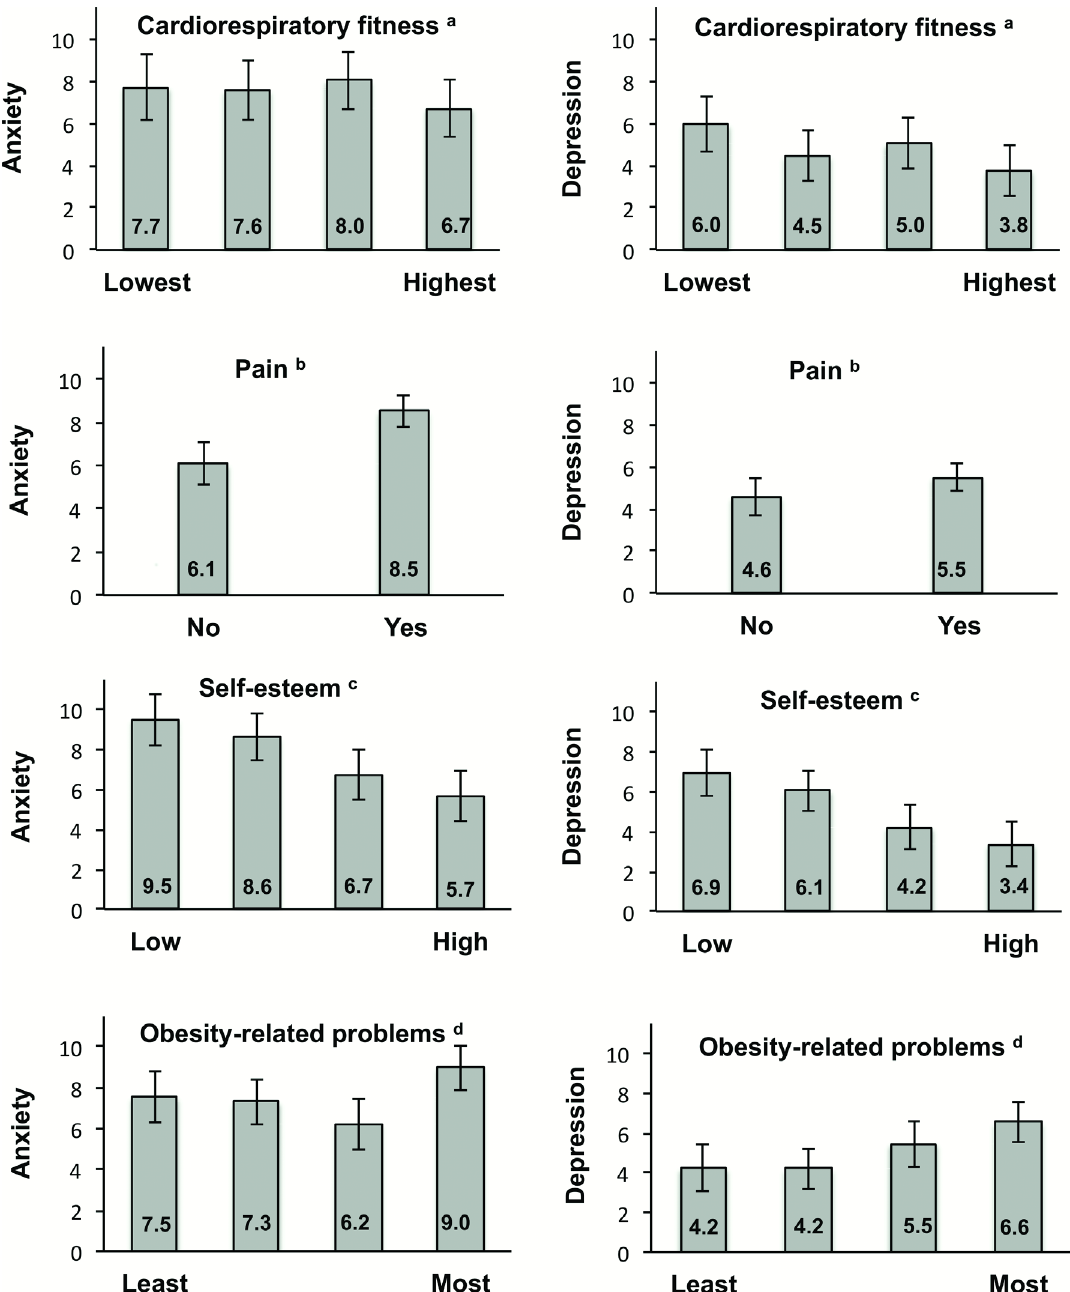
Fig 1. Estimated marginal means across quartiles of cardiorespiratory fitness, pain (yes/no), self-esteem and obesity related problems for anxiety and depression as measured by the Hospital Anxiety and Depression Scale (min-max: 0 – 21) in (n = 165) treatment-seeking young adults (16 – 25 y) with obesity. Values are mutually adjusted (except for cardiorespiratory fitness) for gender, age, body mass index, economic strain, hazardous alcohol consumption, insomnia, Homeostasis Model Assessment-Insulin resistance; and social support (all P > 0.30). Error bars = 95% CI. a Astrand´s test [25]. b European Quality of Life-5 Dimensions [42]. c Rosenberg Self-Esteem Scale [31]. d Obesity-related Problems Scale [33].